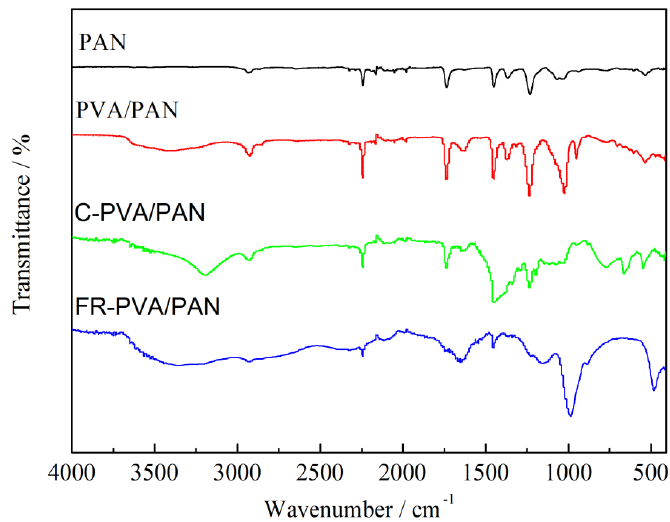
Figure 1. FTIR spectra of PAN, PVA/PAN, C-PVA/PAN, and FR-PVA/PAN fibers.